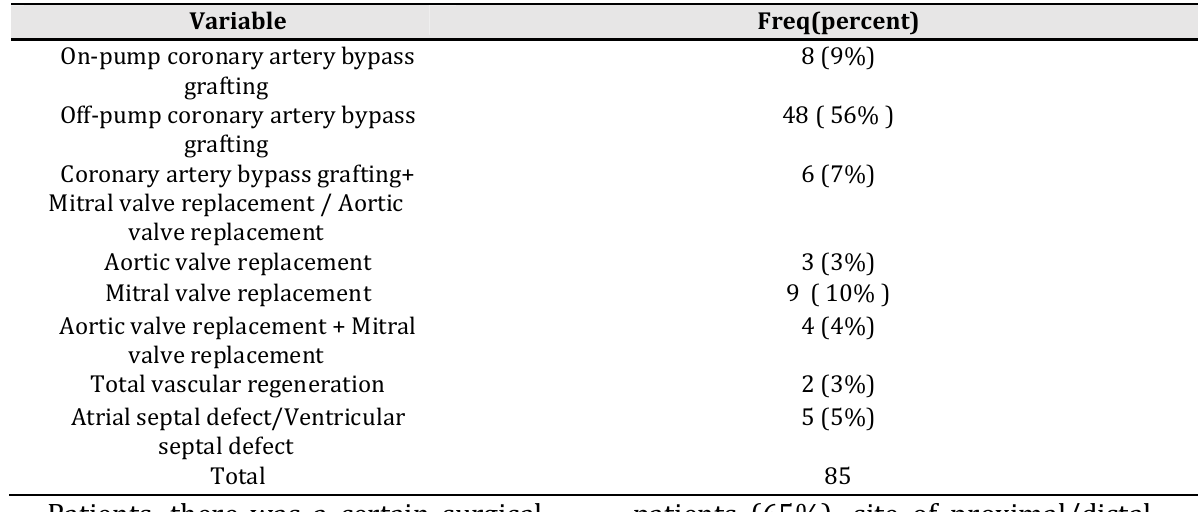
Table 1: Demographic Data of